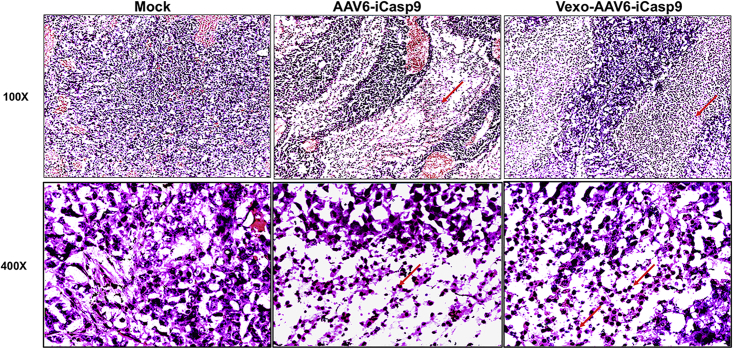
Histological Analysis of Huh7 Xenograft Tumor TissueExcised tumors were sectioned and stained with hematoxylin and eosin at the end of the experiment. Representative images are shown. A notable pyknosis (red arrow) and apoptosis are seen with Vexo-AAV6-iCasp9 vector + AP20187-administered animals (magnifications: top, 100×; bottom, 400×).